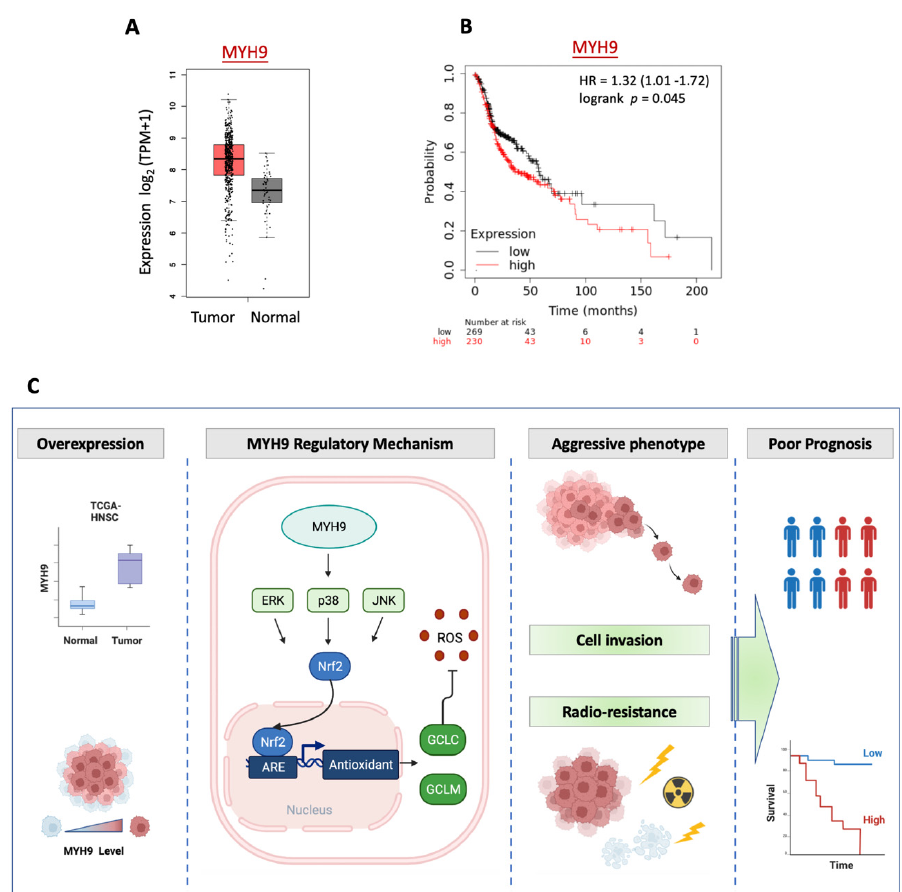
Figure 6. Clinical association of MYH9 in HNC patients. ( A ) Differential expression of MYH9 in HNC and normal tissues, as determined using TCGA ‐ HNSC datasets. ( B ) Prognostic significance of MYH9 in HNC patients, as determined using the TCGA ‐ HNSC dataset by the KM plotter method ( n = 500). The survival curve, hazard ratio (HR), and p ‐ value are indicated. ( C ) A molecular model representing MYH9 regulatory mechanism resulting in cell invasion and radioresistance in HNC cells. MYH9 activates the pan ‐ MAPK signaling molecules, including Erk, p38, and JNK. This activation leads to the induction of Nrf2 transcriptional activity, the upregulation of the antioxidant enzymes, and the reduction of cellular ROS levels. The antioxidant enzyme, such as GCLC, further confers cell invasion and radioresistance, resulting in aggressive cancer and poor prognosis. Taken together, MYH9 exerts malignant effects in HNC via regulating cellular ROS levels by activating the MAPK ‐ Nrf2 ‐ GCLC signaling pathway.